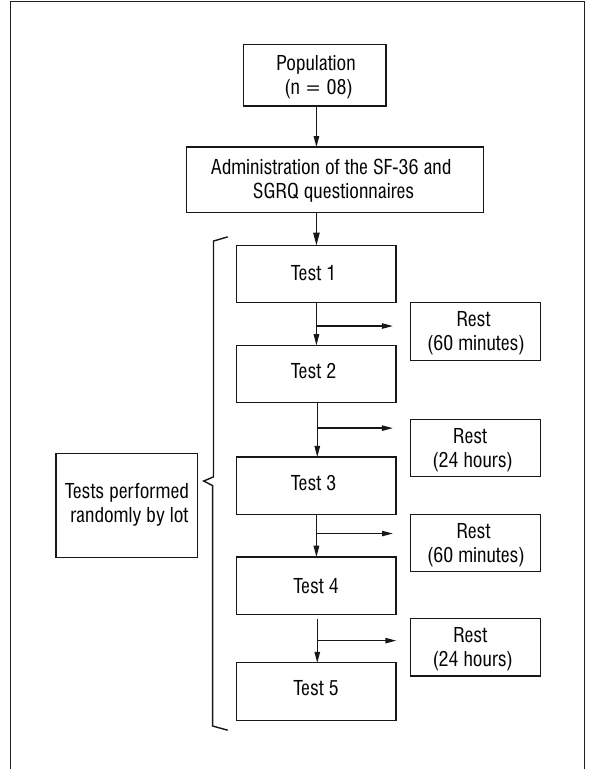
Figure 1 - Experimental protocol